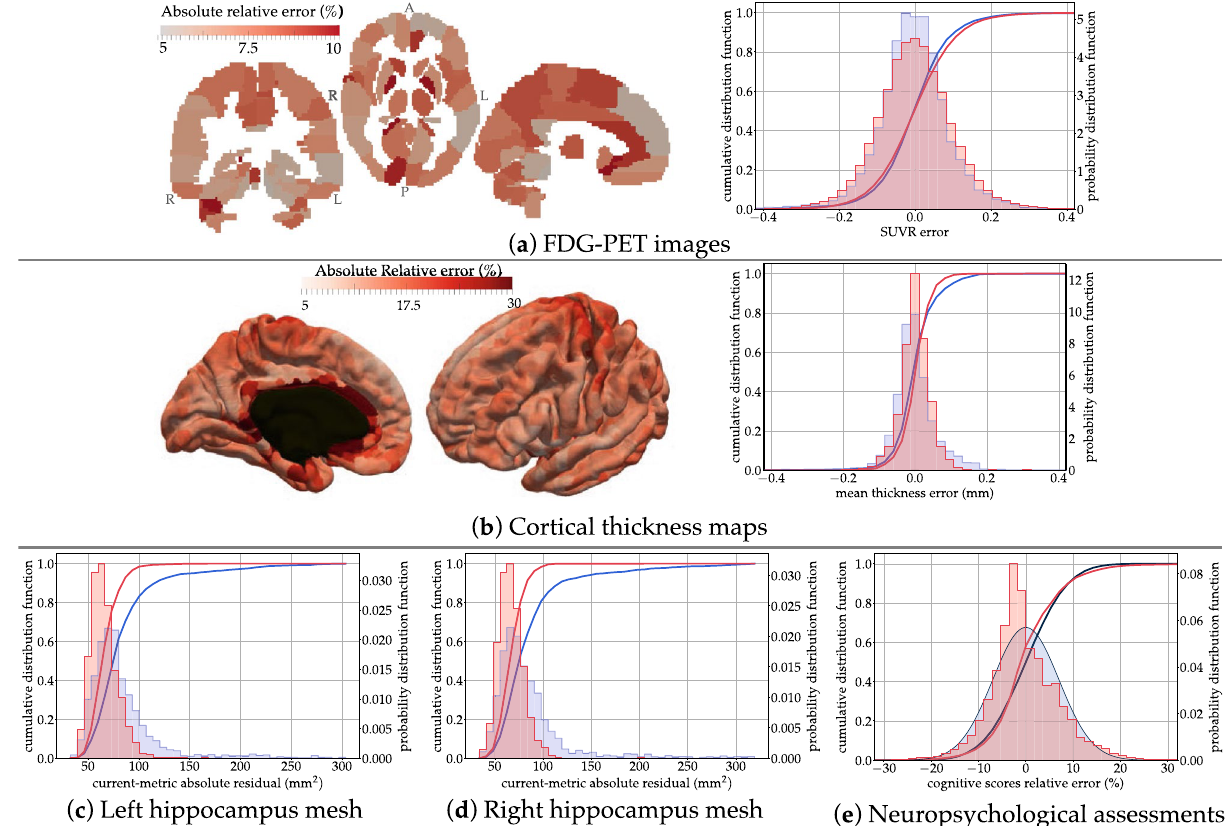
Figure 3. Distributions of reconstruction errors. The empirical distribution of errors (red) is superimposed with the estimated distribution of test / re-test differences (in blue). The absolute relative error is shown in every brain region for FDG-PET images and cortical thickness maps. Mean and standard errors are given in Supplementary Table S1. Images were obtained using the freely available software FSLeyes v.0.22.6 (https:// fsl. fmrib. ox. ac. uk/ fsl/ fslwi ki/ FSLey es) and Paraview v.5.2.0 (www. parav iew.